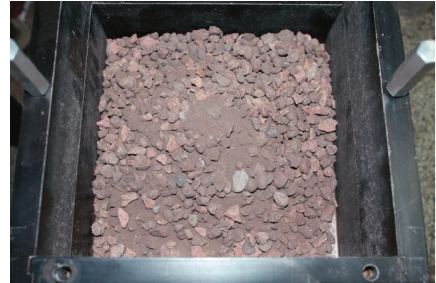
Figure 9: Photograph of rock-soil mixture